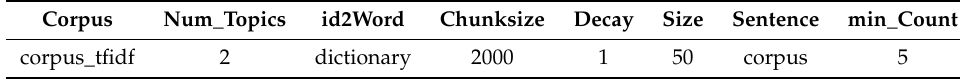
Table 1. The model parameters of LSI-Word2vec.